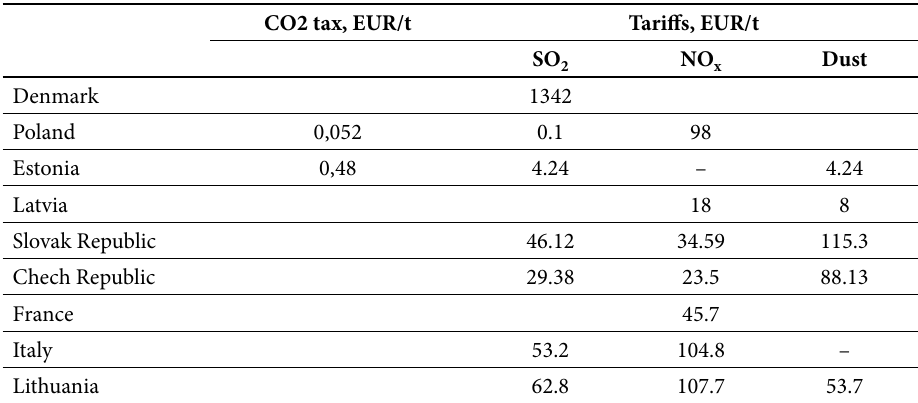
Table 2. Pollution taxes for emissions into atmosphere in some EU member states,